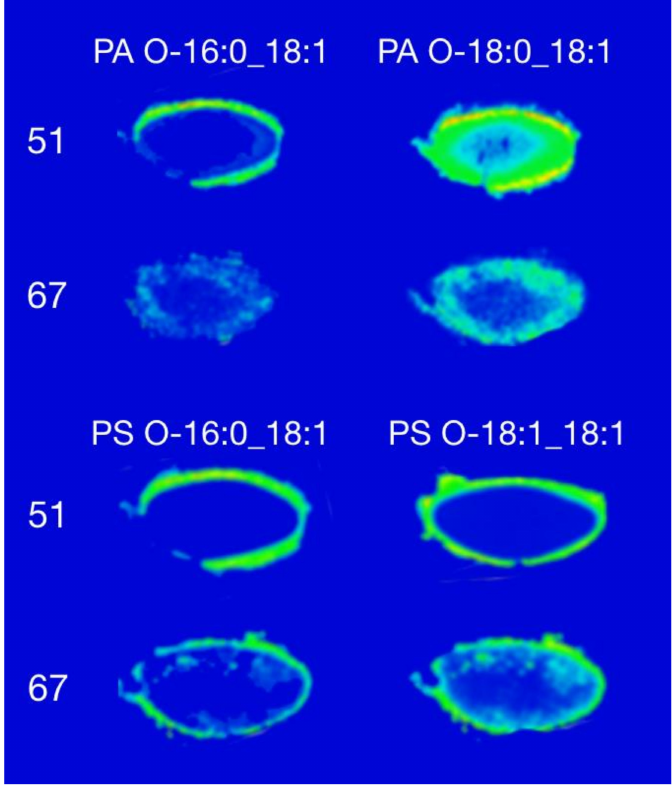
Figure 2. Distribution images of PA and PS in a 51-year-old and 67-year-old human lens. All lipids were detected with [M − H] − in negative ion mode. PA: phosphatidic acid, PS: